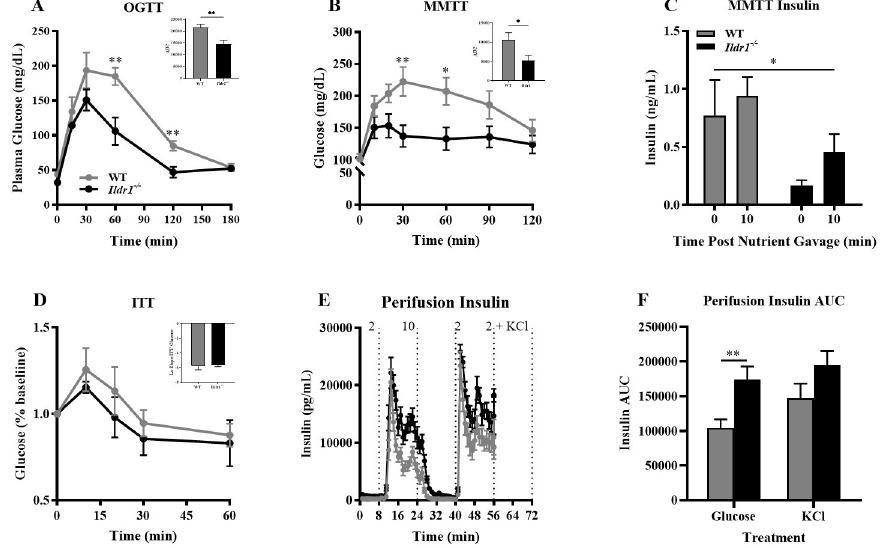
Fig 11. Glucose control and insulin secretion in Ildr1 -/- (black lines/black bars) and wild-type mice (WT, grey lines/grey bars). All tests were performed under low fat diet condition. (A) Oral glucose tolerance test (OGTT) in wild-type (WT, grey lines and grey bars) and Ildr1 -/- mice (black lines and black bars); RMANOVA for time [F(5,40) = 45.183, P < 0.001], genotype [F(1,8) = 8.115, P = 0.022], and time by genotype [F(5,40) = 2.881, P = 0.026]. Inset : Area under the curve (AUC) for OGTT [t(8) = 3.541, P = 0.008]; n = 5 mice/genotype. (B) Glucose excursion in the mixed meal tolerance test (MMTT) in WT and Ildr1 -/- mice: RMANOVA for time [F(6,60) = 11.601, P < 0.001], genotype [F (1,10) = 7.112, P = 0.024], and time by genotype [F(6,60) = 2.426, P = 0.036]; Inset : AUC for MMTT [t(10) = 2.335, P = 0.042]; n = 6 mice/genotype. (C) MMTT insulin measured at 0 and 10 min: step-wise regression for time [R 2 = 0.048; F(1,23) = 1.120, P = 0.301] and genotype from baseline (time 0) to 10 min [R 2 = 0.320; F(2,23) = 4.952, P = 0.017]. (D) Glucose excursion in the insulin tolerance test (ITT) in WT (grey lines/grey bars) and Ildr1 -/- mice (black lines/black bars). n = 6 mice/genotype. (E) Insulin tolerance test (ITT) monitoring insulin secretion from ex vivo glucose- or KCl-perfused WT and Ildr1 -/- islets (n = 6 mice/genotype). (F) Integrated area under the curve for glucose-stimulated insulin secretion ex vivo (8–24 min; from panel E) and KCl-stimulated insulin secretion (40–56 min); for glucose [t(22) = 3.082, P = 0.005, two-tailed]. � P < 0.05, �� P < 0.01 WT vs . Ildr1 -/- .